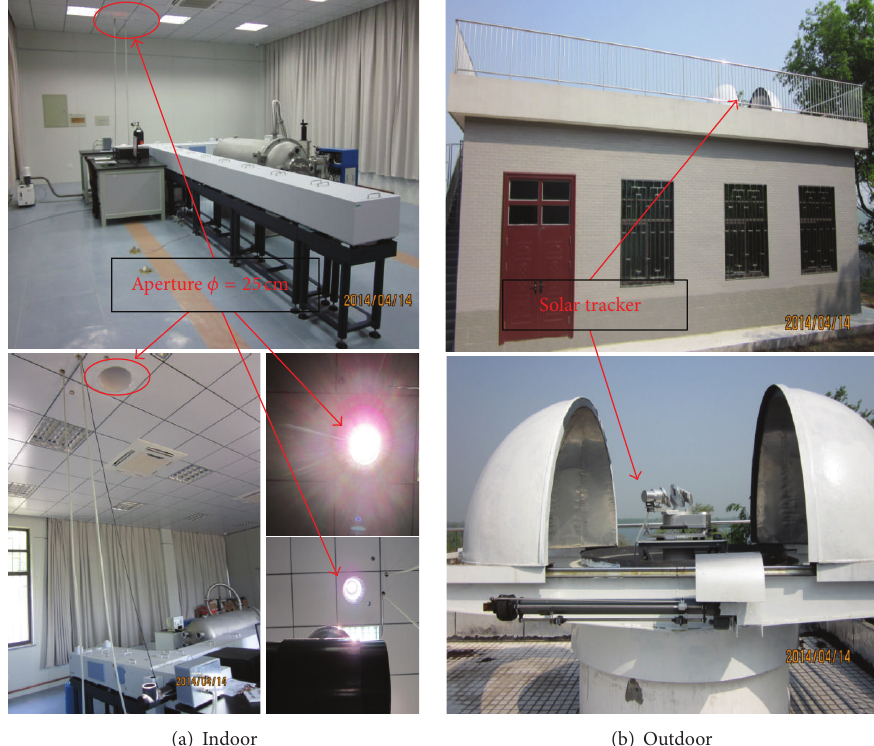
Figure 1: Experimental instrument